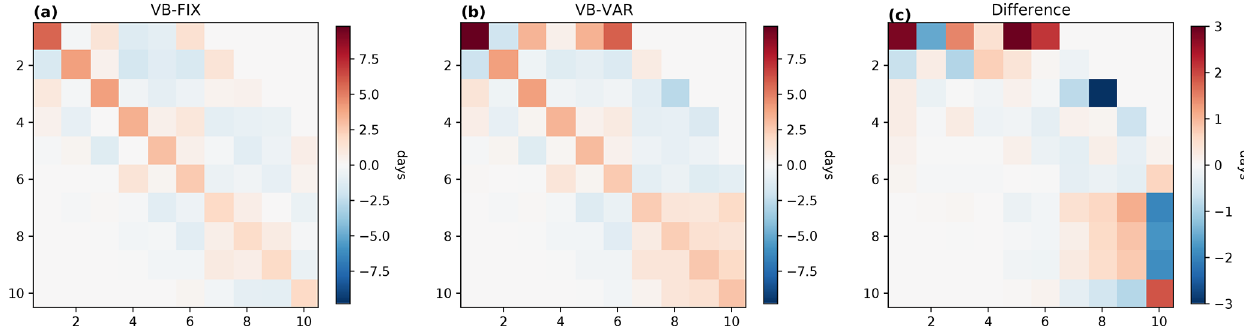
Figure B1. Response matrices ˆ L calculated from the barotropic setups using Eq. (B5) but for practical purposes with an upper integration limit of 40d (a) VB-FIX and (b) VB-VAR. These are the ˆ L matrices used to make the predictions in Fig. 6, shown here in their respective EOF bases. (c) Difference between panels (a) and (b) in the EOF basis of the OFF control experiment, highlighting the impact of interannual VB